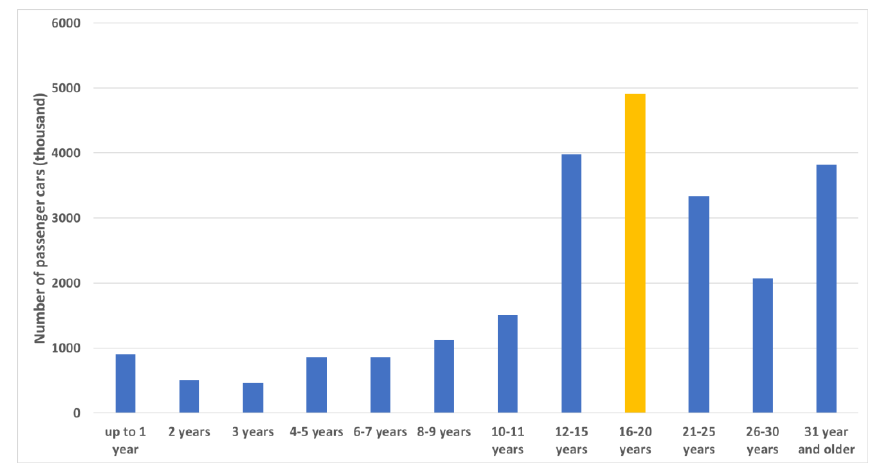
Figure 1. Passenger cars in Poland by age groups in 2019 (based on [52]).